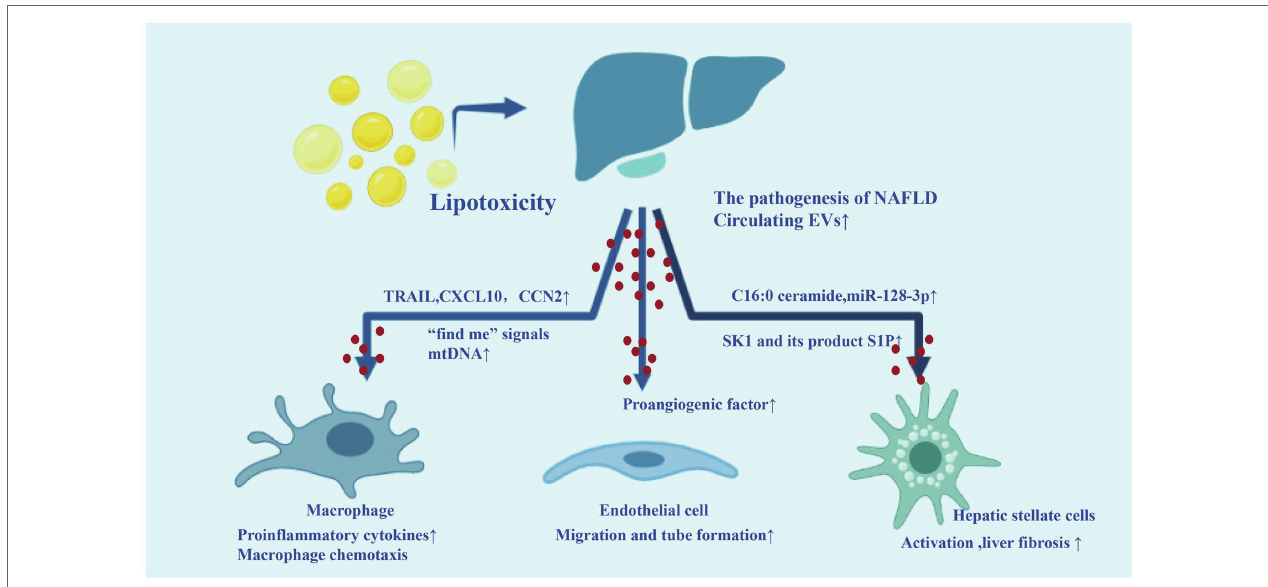
FIGURE 3 | Extracellular vesicles in the development of non-alcoholic fatty liver disease (NAFLD). During the process of lipotoxicity, a large number of EVs released from liver carry inflammatory molecules to liver non-parenchymal cells (macrophages, HSCs, and endothelial cell), which can promote liver inflammation, angiogenesis, and